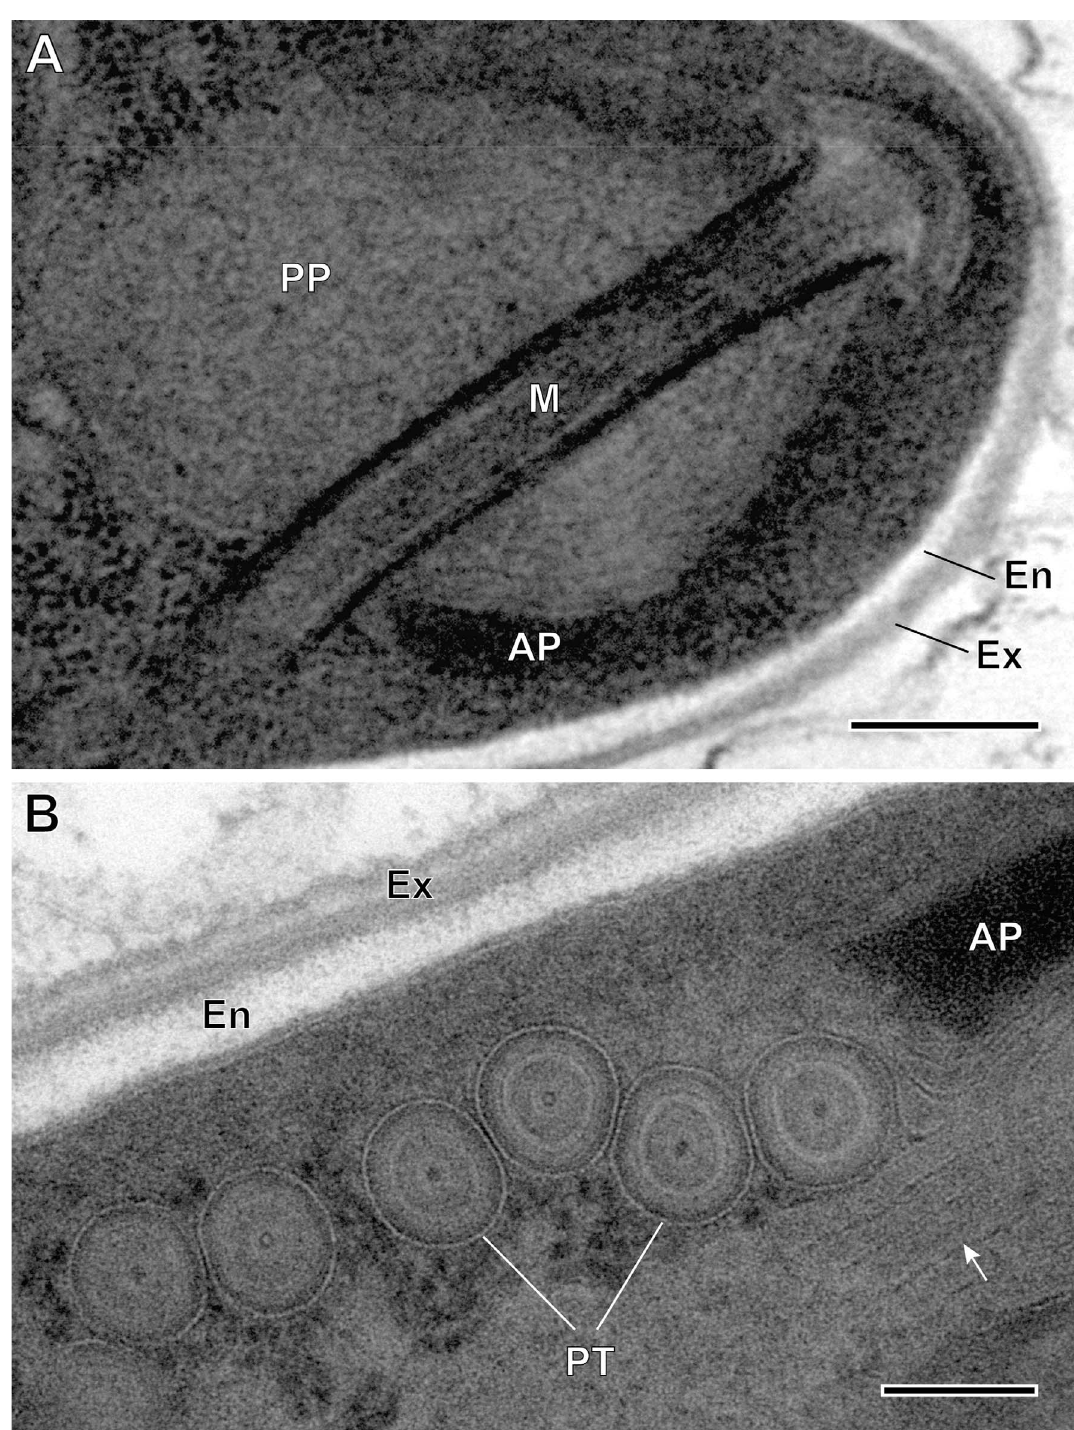
Figure 9. Ultrastructural details of mature spores of Toguebayea baccigeri n. gen., n. sp. (A) Detail of the apical part showing the manubrium (M); (B) Detail showing cross-sections of the polar tube (PT) composed of several concentric electron-dense and electron lucent layers surrounding a central tubular structure. Note the lamellar external area (white arrows) of the posterior polaroplast (PP). AP, anterior polaroplast; En, endospore; Ex, exospore. Scale bars: A = 0.2 l m; B = 0.1 l